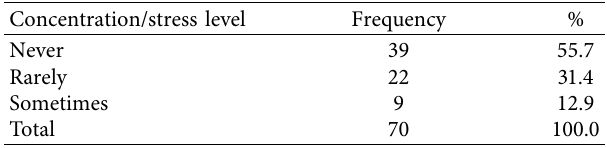
Table 23: Concentration/stress level.